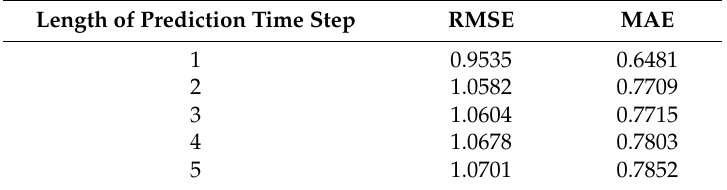
Table 4. Impacts of the length of the prediction time step on the prediction